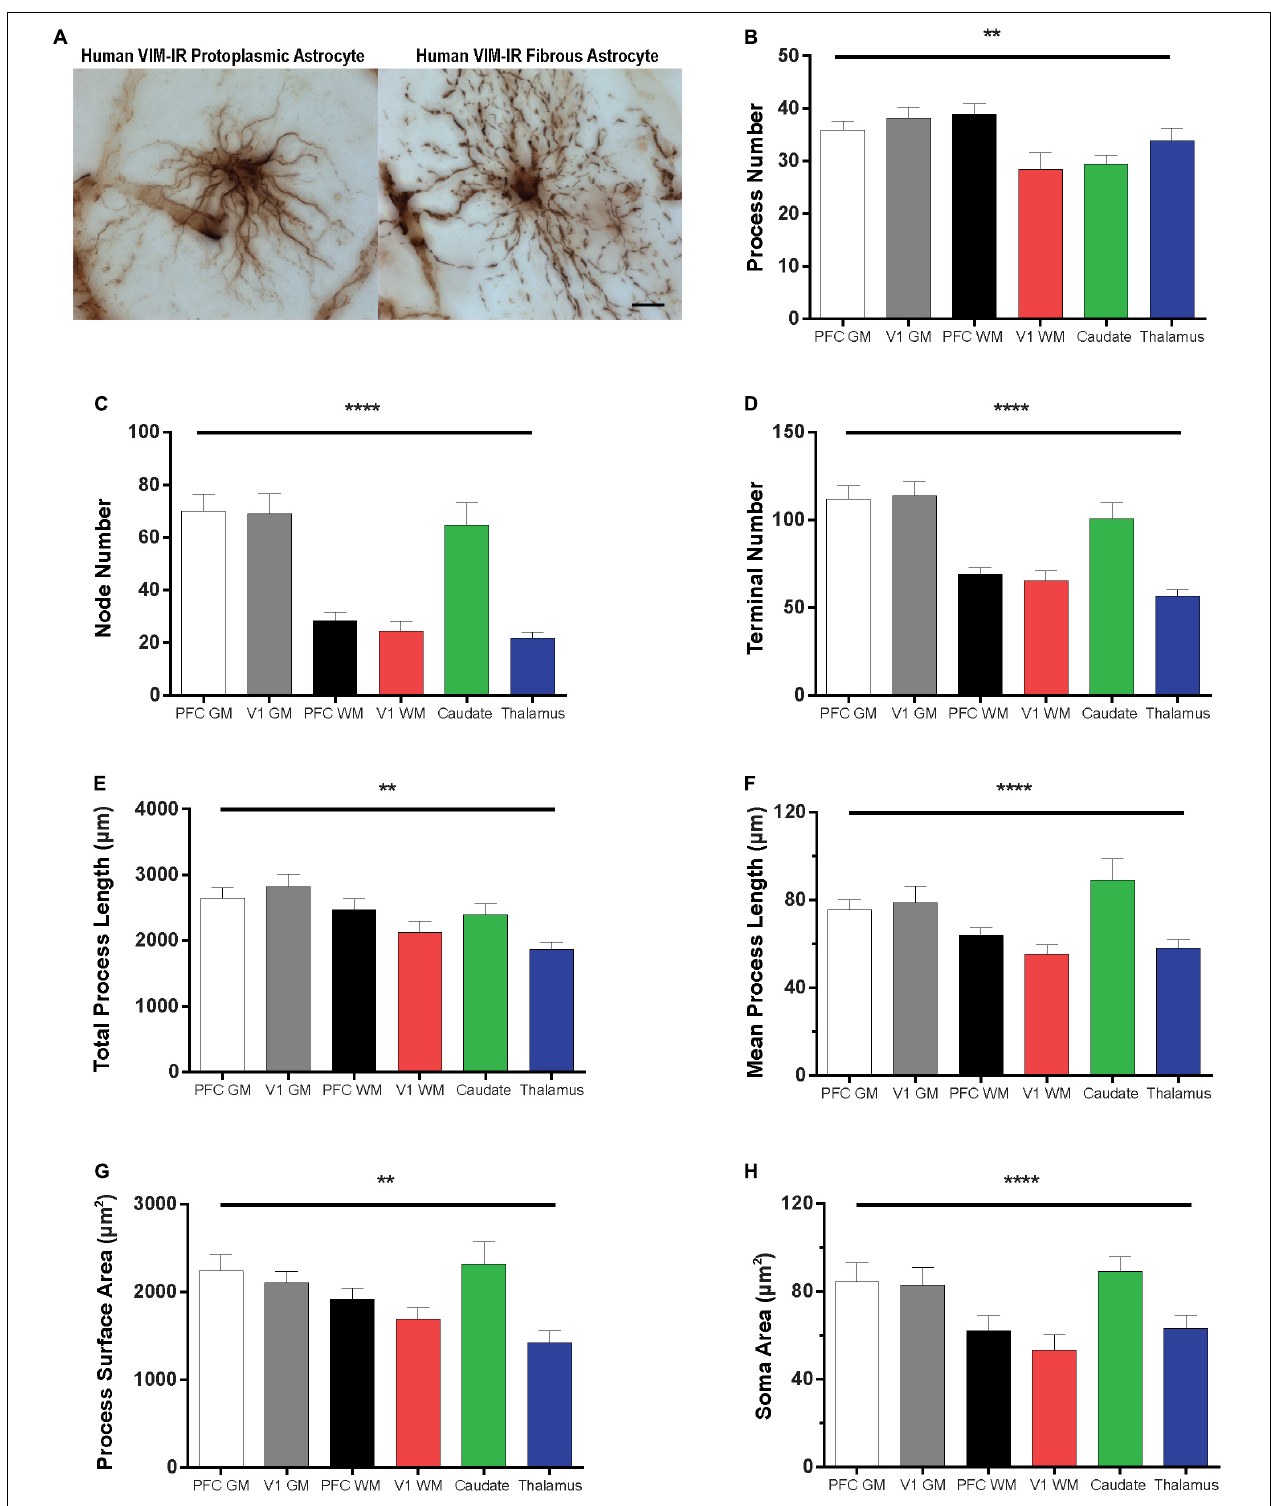
FIGURE 6 | Regional heterogeneity in human VIM-IR astrocyte morphometry. (A) Representative VIM-IR astrocytes from prefrontal cortex gray matter (left) and white matter (right). (B–H) Branched Structure Analysis (BSA) of VIM-IR astrocytes revealed morphometric differences across markers and regions. BSA measurements for VIM-IR astrocytes were generally similar for cortical gray matter and caudate nucleus, and for cortical white matter and mediodorsal thalamus. Scale bars = 50 µ m. ** p ≤ 0.01, **** p ≤ 0.0001 ( n = 5; Friedman Test).